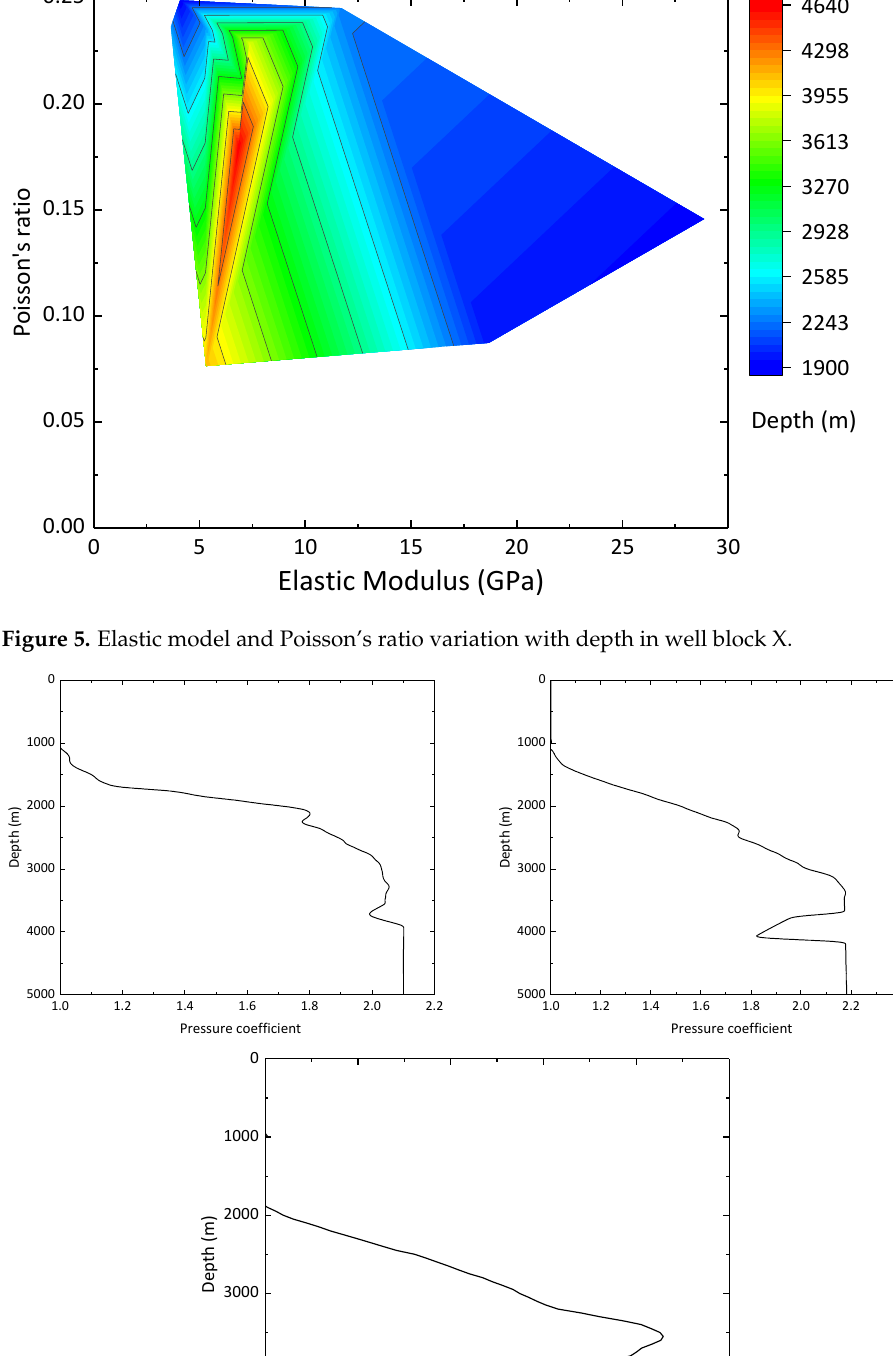
Figure 6. Pressure profile of wells X-1, X-2, and X-4 .